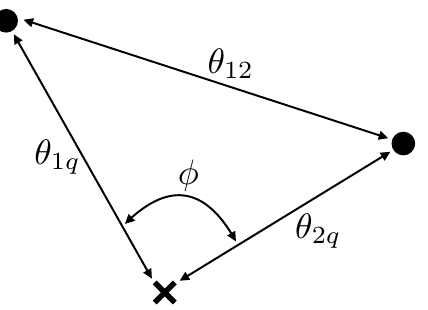
Figure 1: Illustration of the configuration of two gluons (dots) about a quark (cross) in the collinear limit on the celestial sphere. Relative angles between pairs of particles and about the direction of the quark are